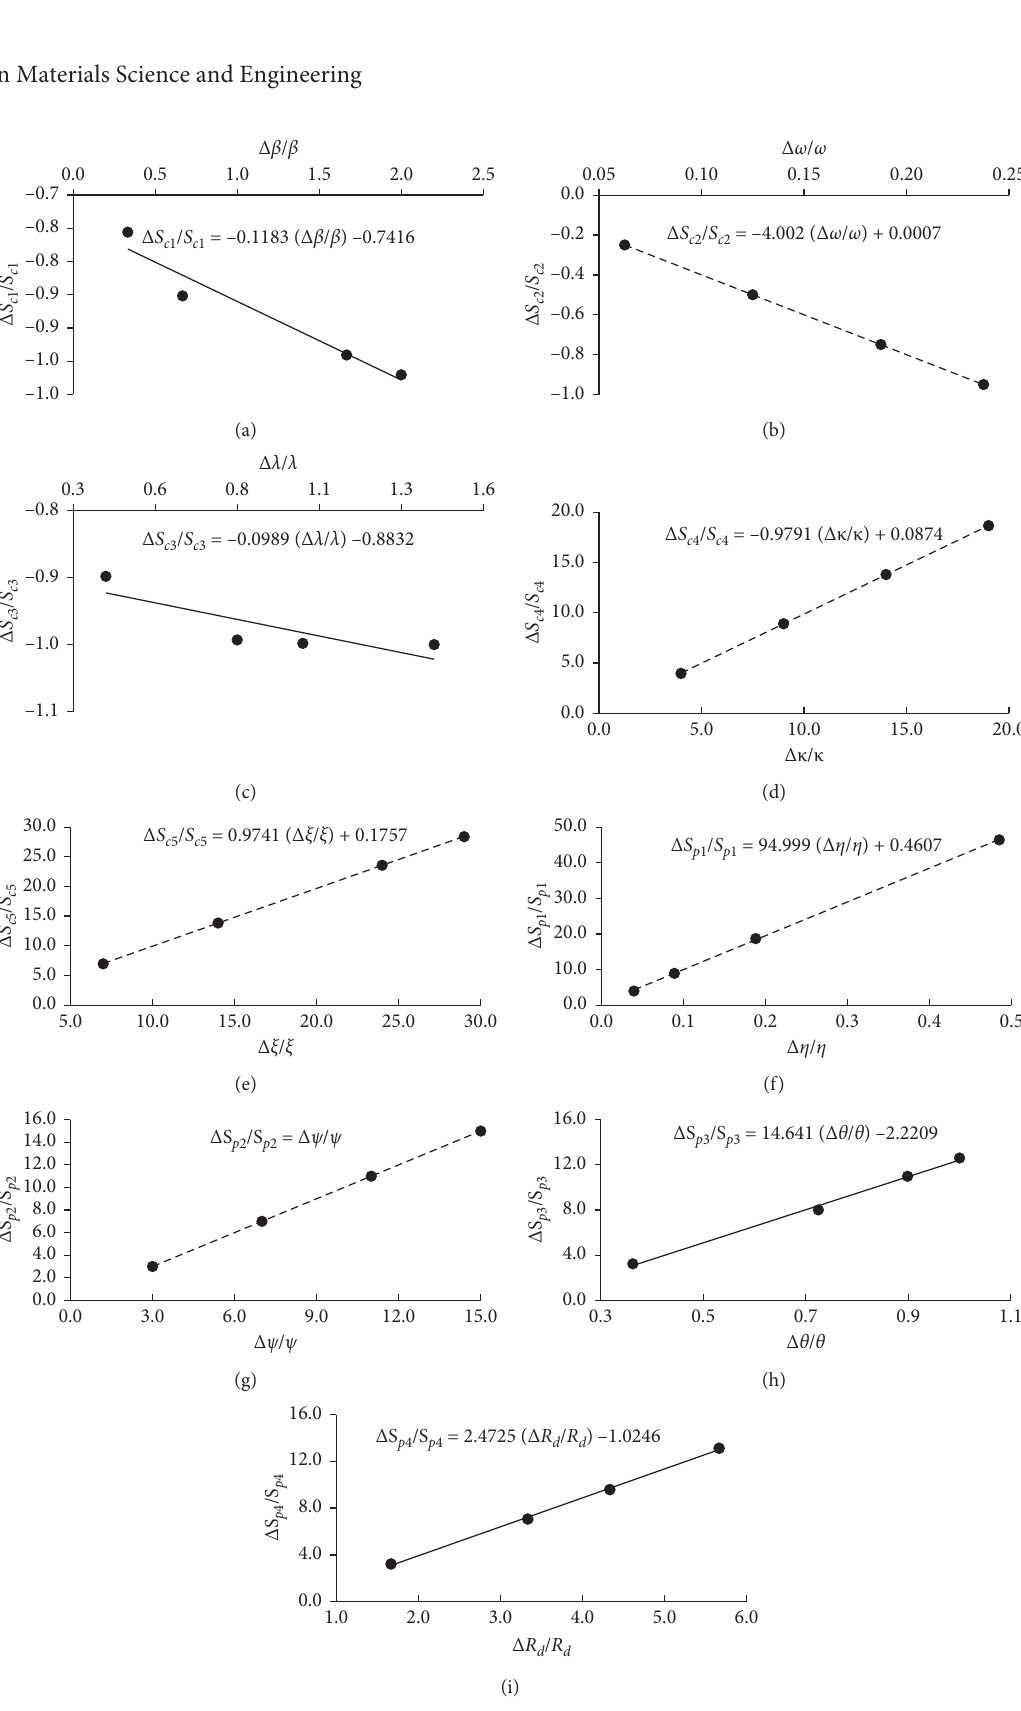
− Δ β / β ,(b) Δ S − Δ ω / ω ,(c) Δ S − Δ λ/λ ,(d) Δ S c 1 / S c 1 c 2 / S c 2 c 3 / S c 3 c 4 /